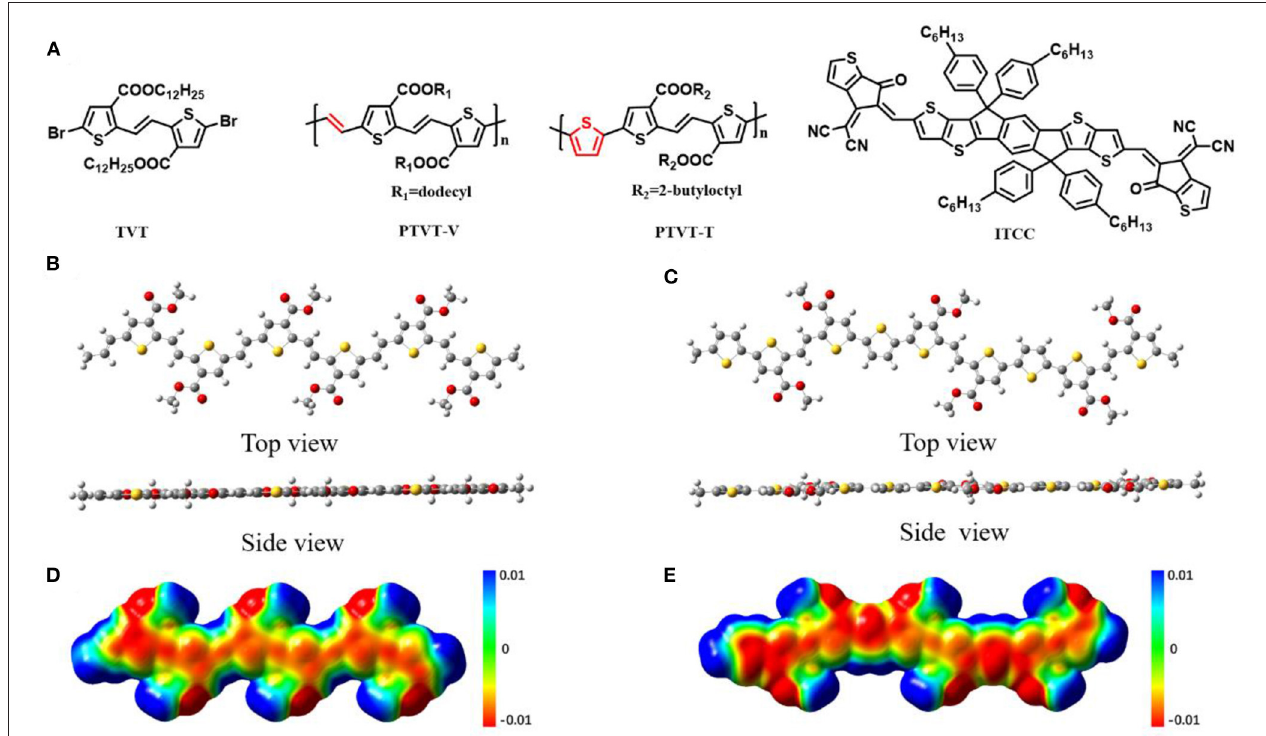
FIGURE 1 | (A) Molecular structures of the TVT monomer, PTVT-V, and PTVT-T. The top-view and side-view of optimized geometries of (B) PTVT-V and (C) PTVT-T. ESP distributions of (D) PTVT-V and (E) PTVT-T.